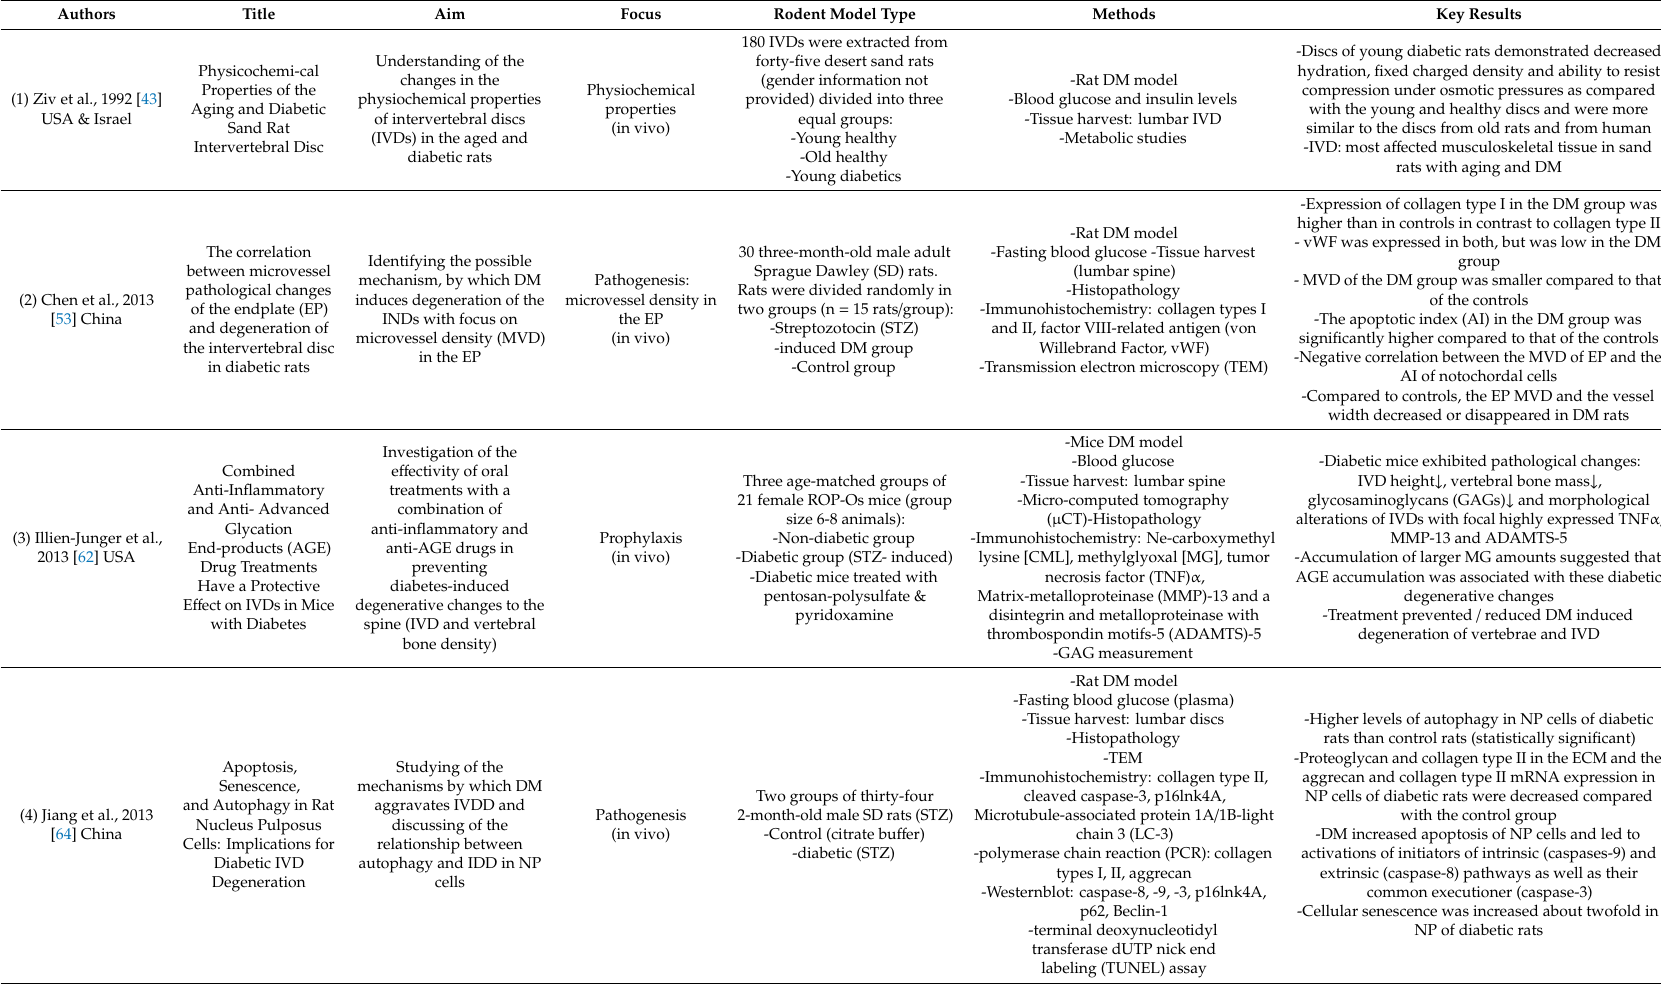
Table 4. Included studies (The results and aims are mainly cited in the own words of the original